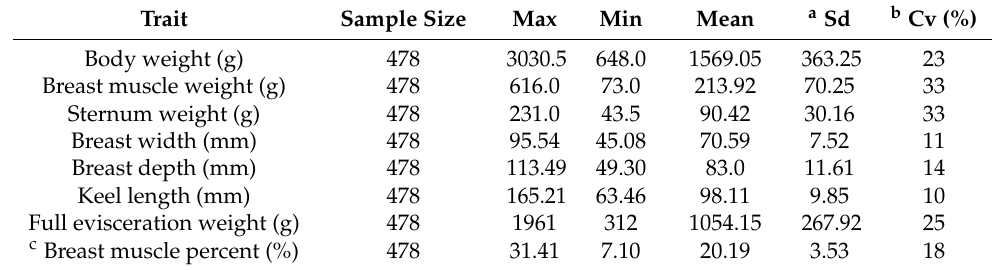
Table 4. The traits of breast muscle development-related traits in the F2 population.